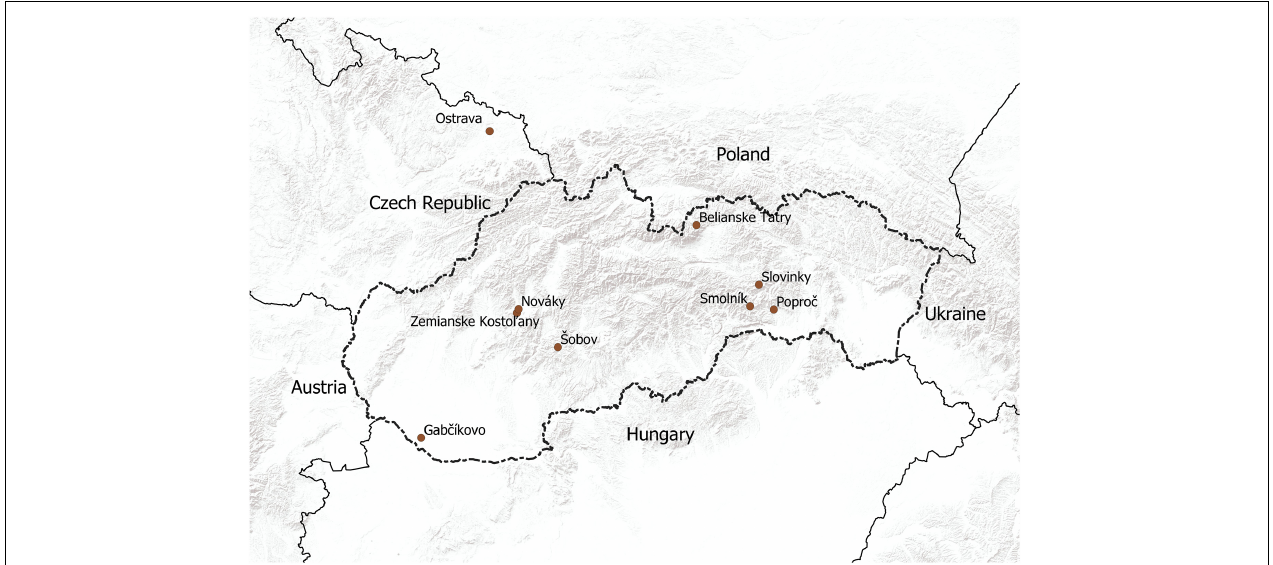
FIGURE 1 | Map showing the sampling localities in Slovakia and the